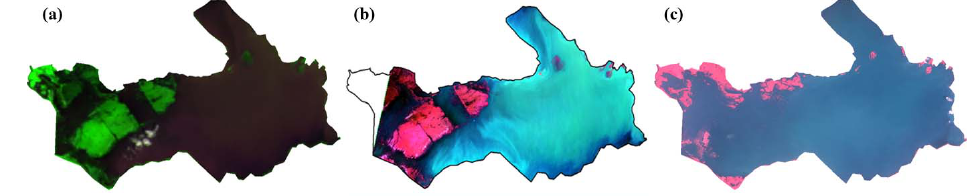
Figure 12. Comparison of PROBA-V image, Sentinel-2 image and Landsat 8 image in 2018. ( a ) PROBA-V image on 26 June 2018; ( b ) Sentinel-2 image on 26 June 2018; ( c ) Landsat 8 image on 31 July